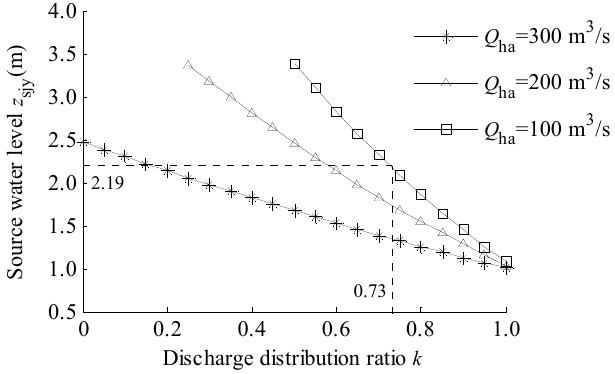
Figure 6. Relationship between source water level and discharge distribution ratio. Table 2. Feasible interval of k under the constraints of water level.